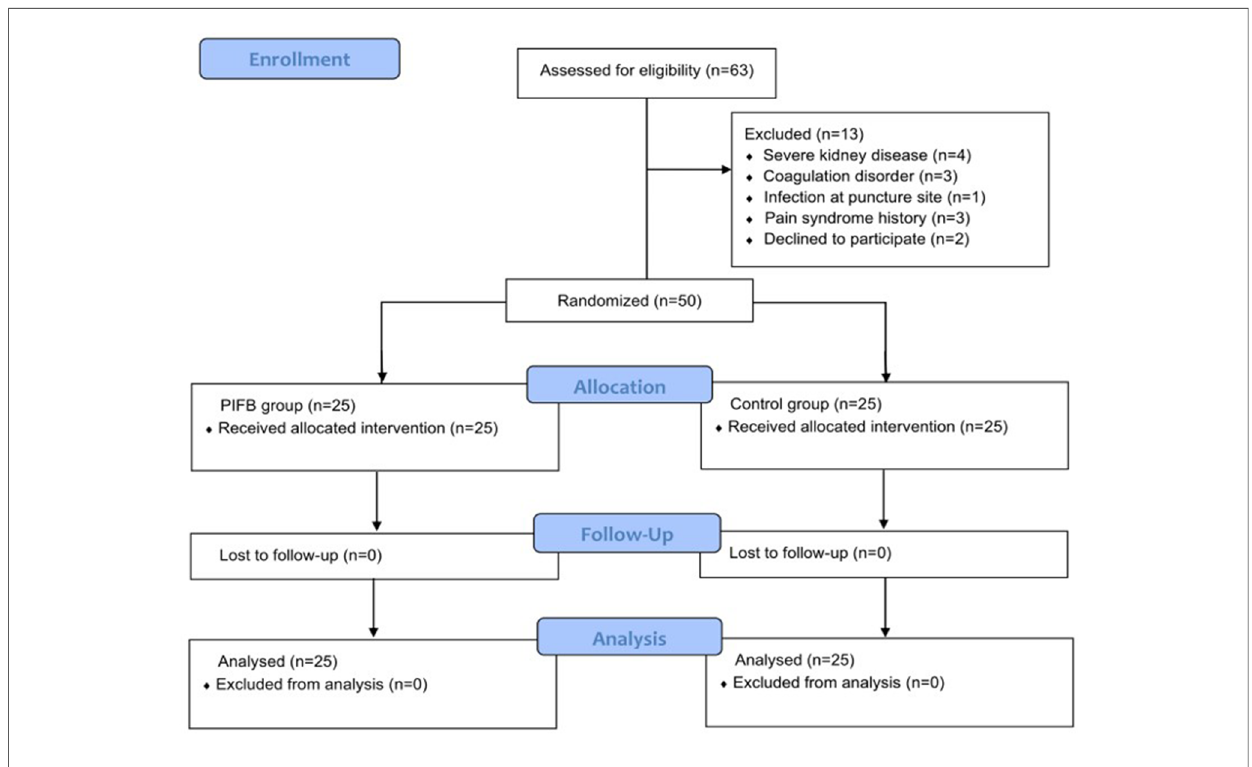
FIGURE 2 Patient fl ow through the trial.